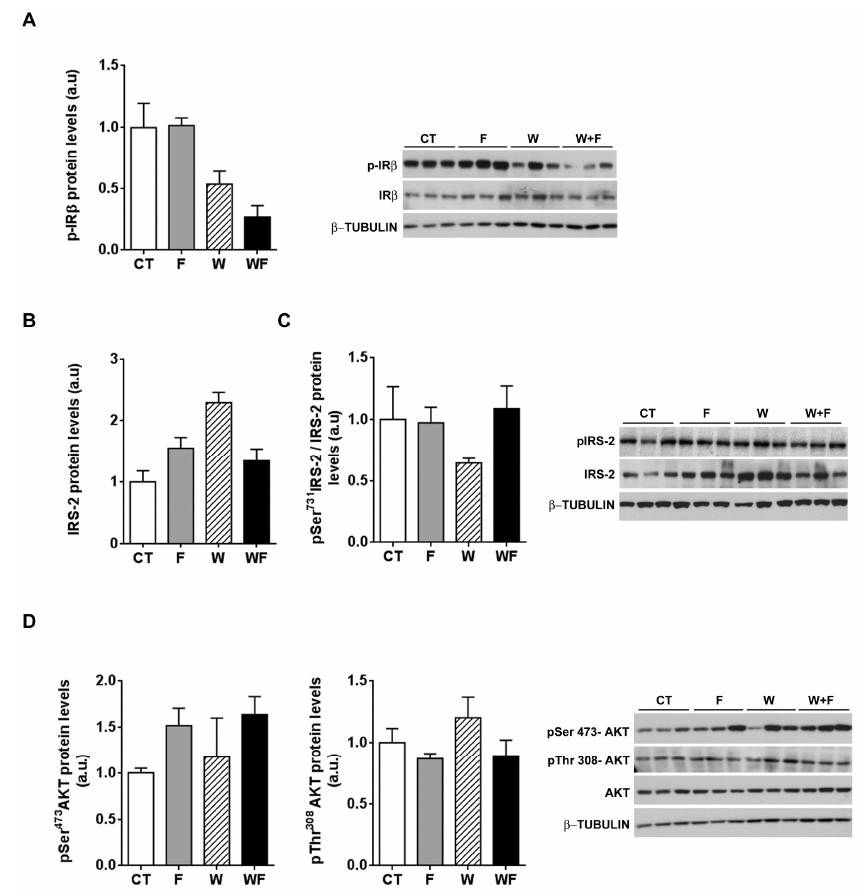
Figure 6. Insulin receptor signalling after an acute insulin challenge. Western-blot of total and phosphorylated IR- β ( A ), IRS-2 ( B , C ) and Akt ( D ) proteins in liver samples obtained from the different experimental groups, after exogenous insulin administration (0.15 units/g body weight). Representative bands corresponding to three different mice in each group are shown; bar plots show the level of the proteins expressed as the mean (a.u., arbitrary units) ± SEM of the values obtained from three to four animals. For IRS-2, as the corresponding total protein levels vary significantly between groups, the bar plot shows the ratio between phosphorylated and total protein